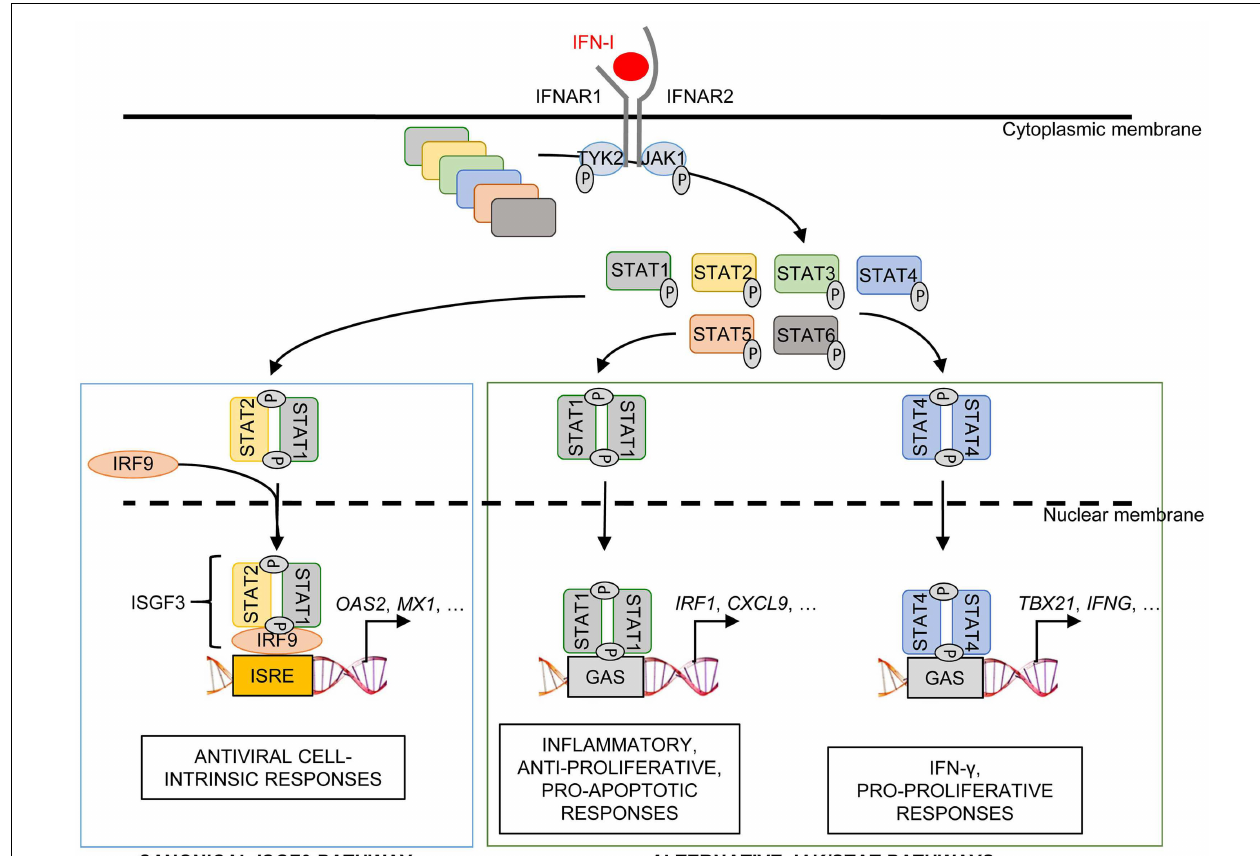
response elements (ISRE), to activate the expression of many interferon-stimulated genes (ISGs). In particular, ISGF3 induces most, if not all, of the ISGs encoding effector molecules of cell-intrinsic anti-viral defenses such as OAS or MX1. Alternative JAK/STAT pathways include the formation of STAT1 or STAT4 homodimers, which may drive different functional responses to IFN-I. STAT1 homodimers bind to IFN γ -activated sequences (GAS) in the promoter of certain ISGs, which may promote inflammatory, anti-proliferative, and pro-apoptotic responses. STAT4 homodimers also bind to GAS but promote IFN- γ production and pro-proliferative